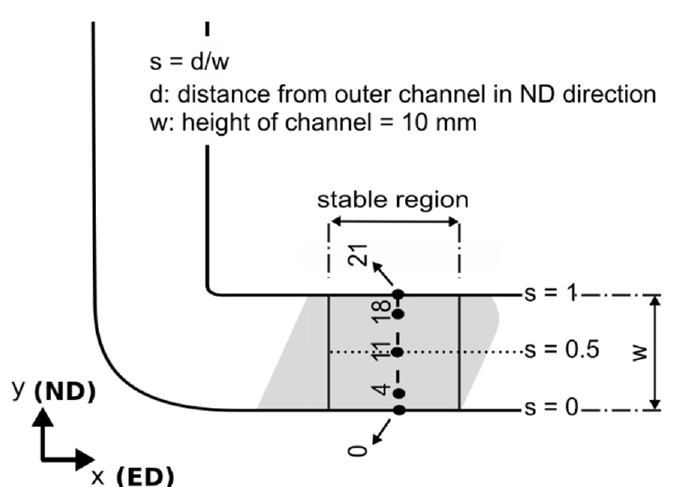
Figure 5. Indication of the directions and the points selected to carry out part of the strain analysis and microhardness measurements.